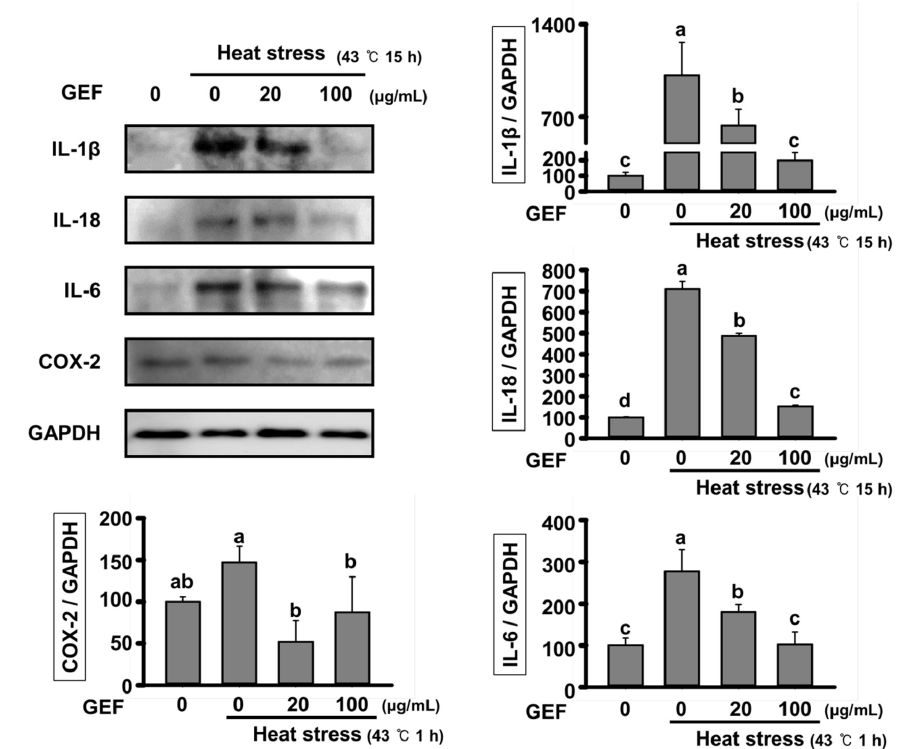
Figure 3. Expression of inflammatory cytokines in C2C12 cells under heat-exposed conditions Expression of interleukin (IL)-18, IL-1β, IL-6 and COX-2 analyzed by Western blot. The density of IL-18, IL-1β, IL-6 and COX-2 versus GAPDH was quantified and expressed as a bar graph, respectively. Values labeled with different letters are significantly different ( p <